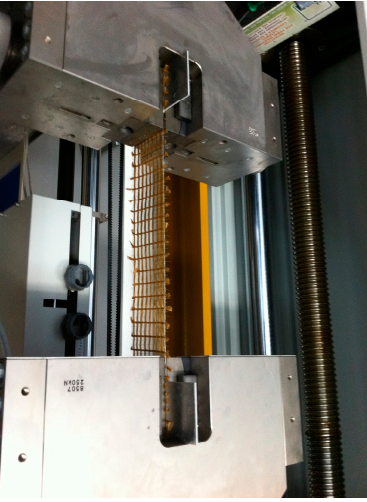
Figure 3. Tensile test carried out on the PBO mesh woven instrumented with FBG and strain gauge: Experimental set-up.